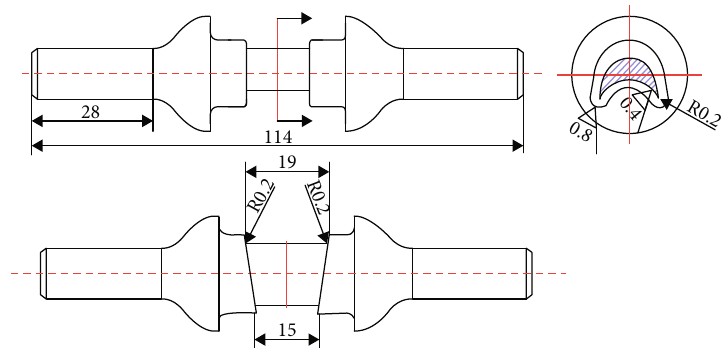
Figure 10: Using 702 to machine the suction side in immersion oil.